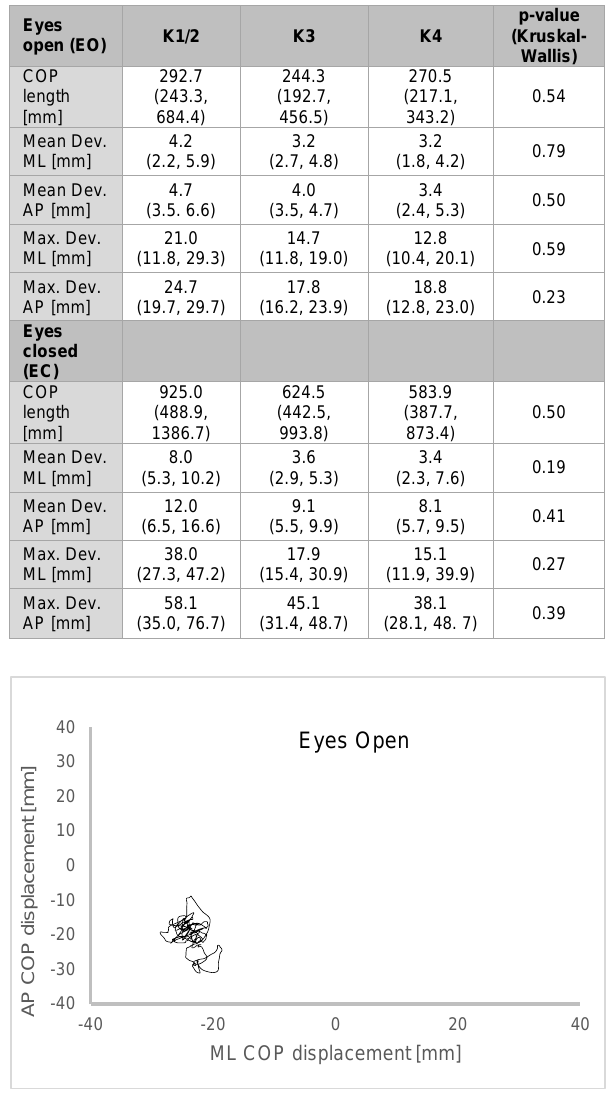
Table 3: COP parameters of the bipedal stance presented as median and IQR (25 th percentile, 75 th percentile).